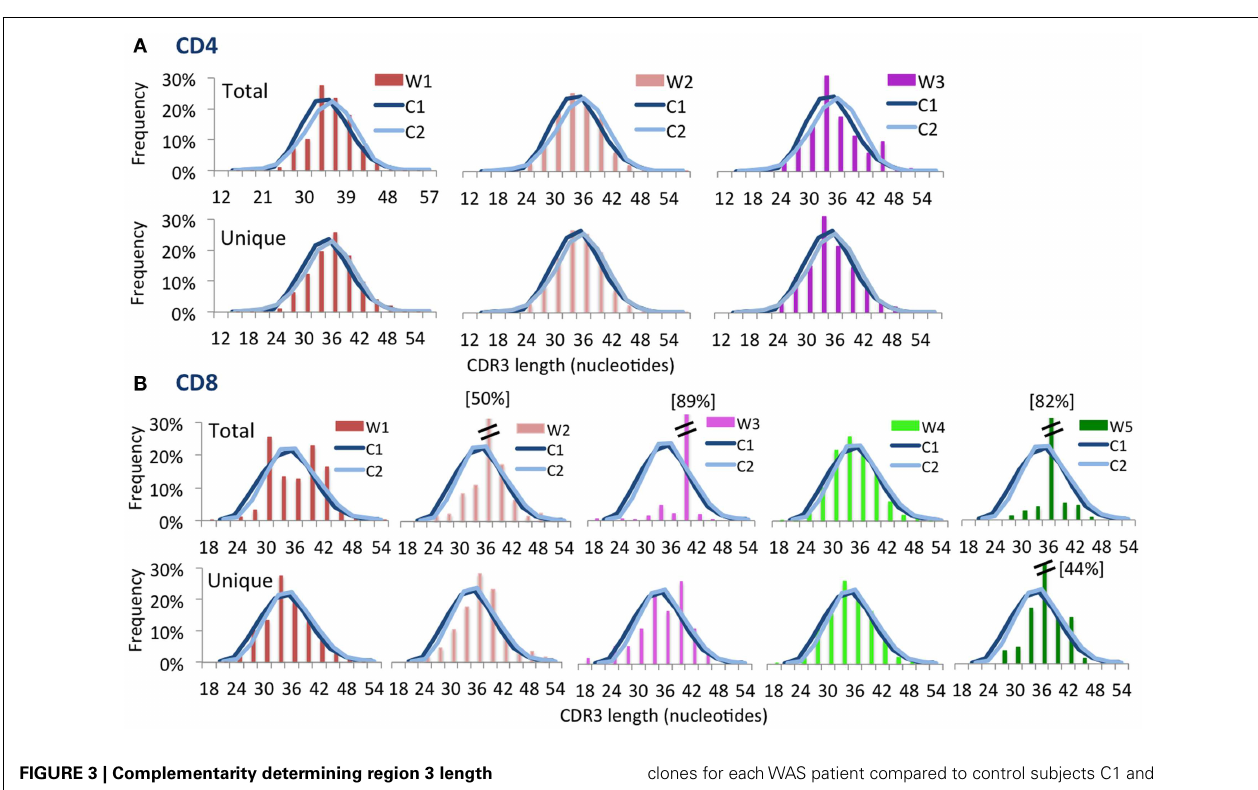
FIGURE 3 | Complementarity determining region 3 length distribution of unique and total sequences for CD4 + and CD8 + TRB repertoire . Distribution of CDR3 nucleotide length frequencies of CD4 + (A) and CD8 + (B) populations for both total and unique